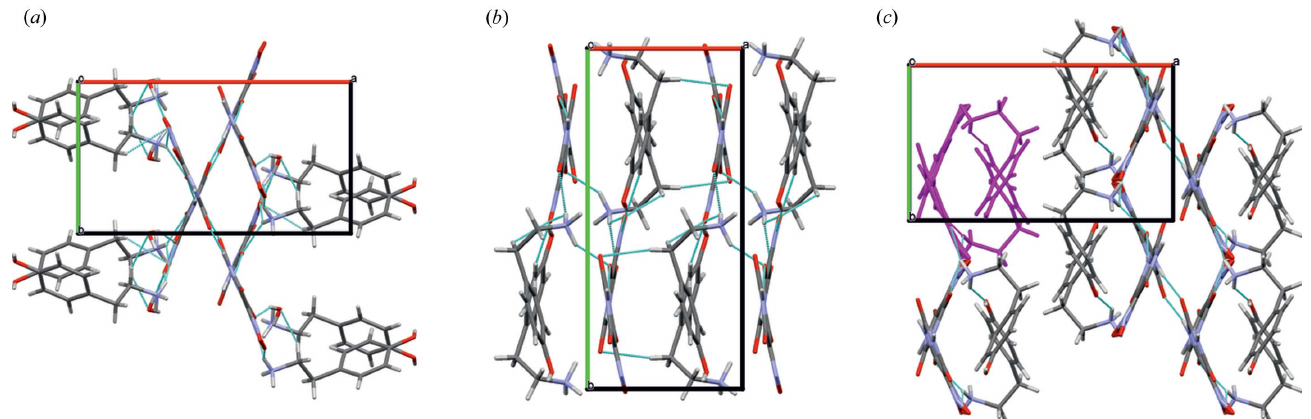
Figure 4 Packing of the molecules in the crystals of ( a ) (I), fragment of the unit cell (0,1/2 c ), ( b ) (II), and ( c ) (III), all along the [001] direction. Heart-shaped motifs are marked in